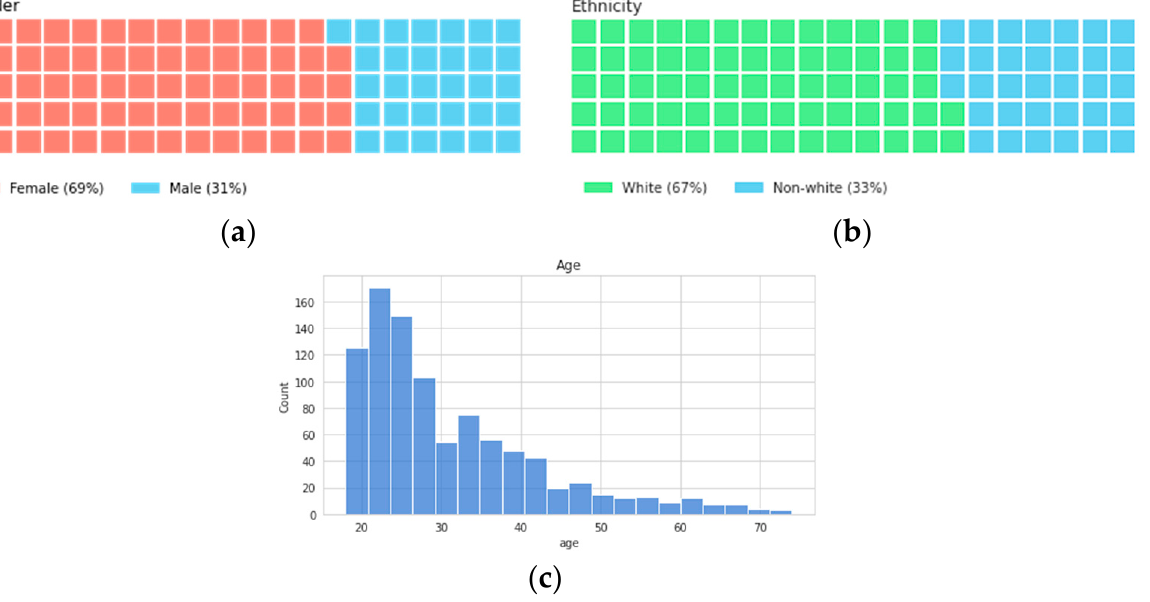
Figure 2. Distribution of participants by ( a ) gender, ( b ) ethnicity, and ( c ) age.